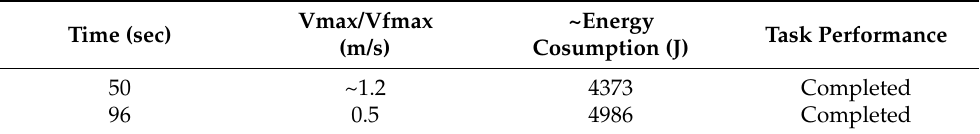
Table 8. Minimum energy